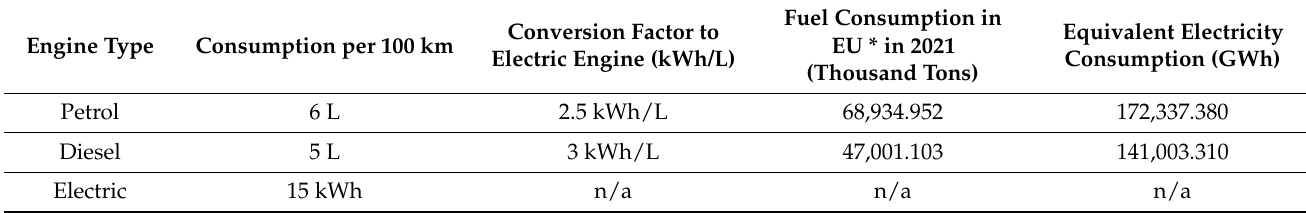
Table 5. Fuel consumption and equivalence in GWh for different engine